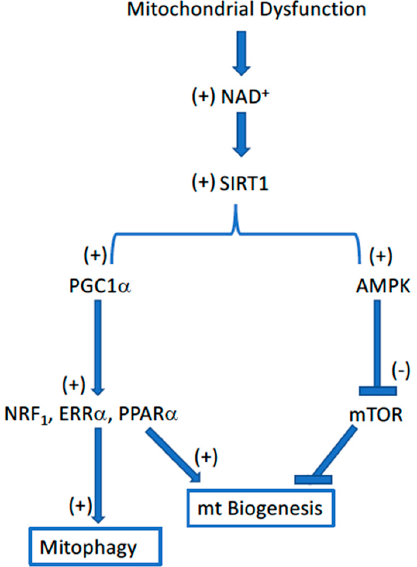
Figure 2. Flow diagram illustrating the interrelationships governing mitochondrial homeostasis in response to the loss of mitochondrial function, such as that which occurs with aging. The Sirt1-dependent regulation of both PGC1 α and AMPK provides a well-controlled integration of the disposal of dysfunctional mitochondria (mitophagy) and their replacement with new, supposedly fully functional, mitochondria (biogenesis).